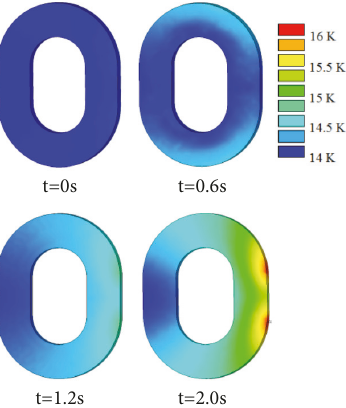
Figure 11: Temperature distribution of TF coil along with time in operational condition B when I